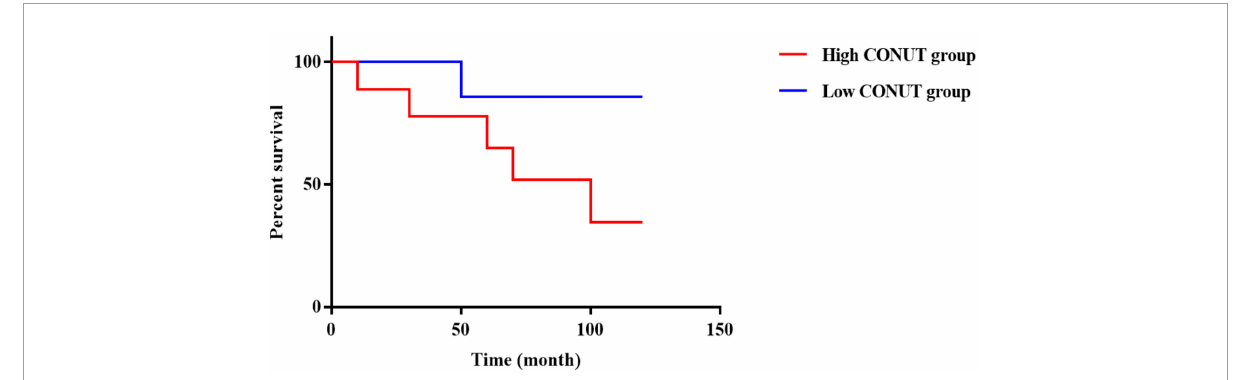
FIGURE2 The high Controlling Nutritional Status (CONUT) group and the low CONUT group survival